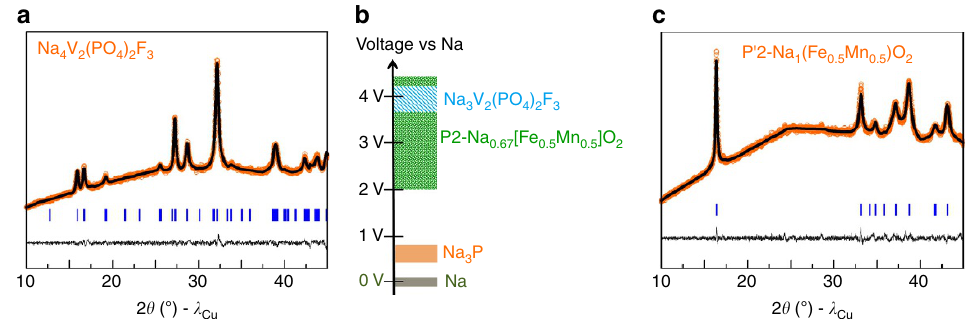
Figure 5 | Synthesis of Na 4 V 2 (PO 4 ) 2 F 3 and P 0 2 phase by Na 3 P ball milling. The XRD Rietveld refinement of ( a ) Na 4 V 2 (PO 4 ) 2 F 3 and the profile matching of ( c ) P 0 2-Na 1 [Fe 0.5 Mn 0.5 ]O 2 phase obtained by ball milling using Na 3 P as a reducing reagent are shown together with in the middle an electrochemical scale ranking the various used compounds in terms of redox potentials ( b ). In a , c the orange open circles, black continuous line and bottom grey line represent the observed, calculated, and difference patterns, respectively. Vertical blue tick bars mark the Bragg